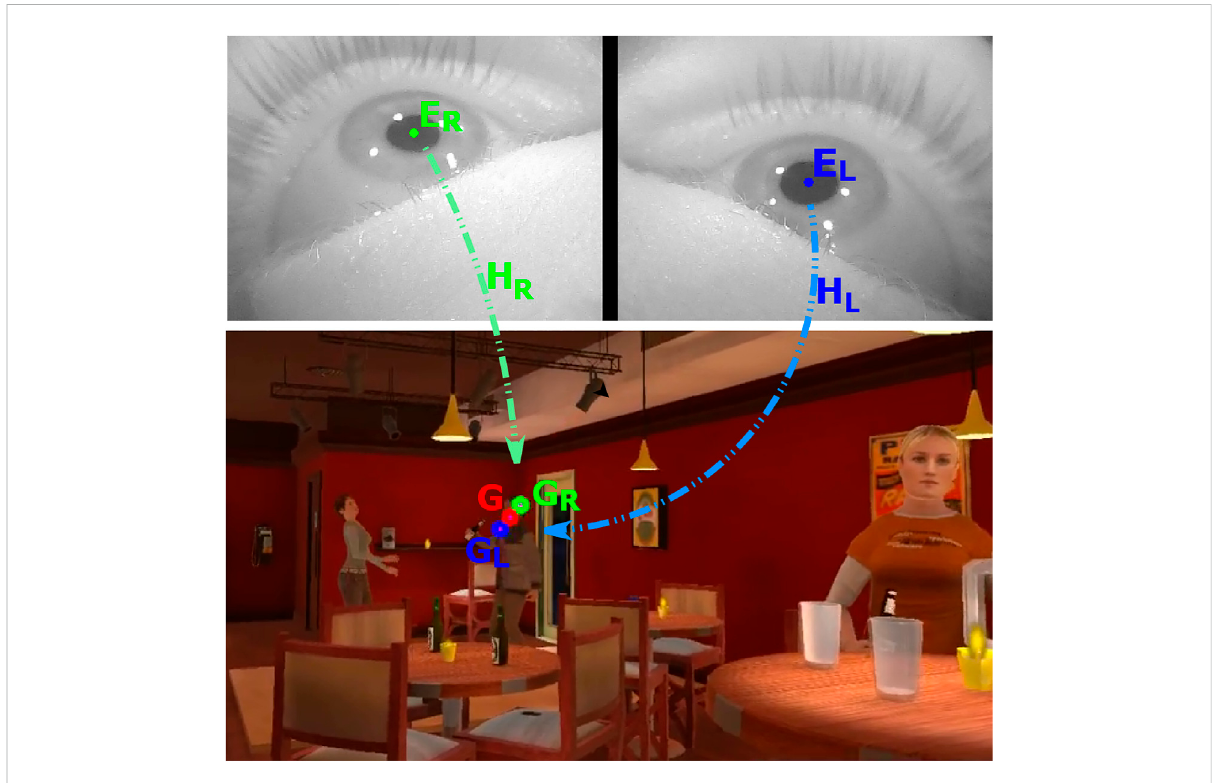
FIGURE 1 The center of the left pupil (EL) and right pupil (ER) are mapped to two points (GL,GR) on a plane in front of the subject via the homography matrices HL and HR. The gaze point (G) is computed as the mean of GL and